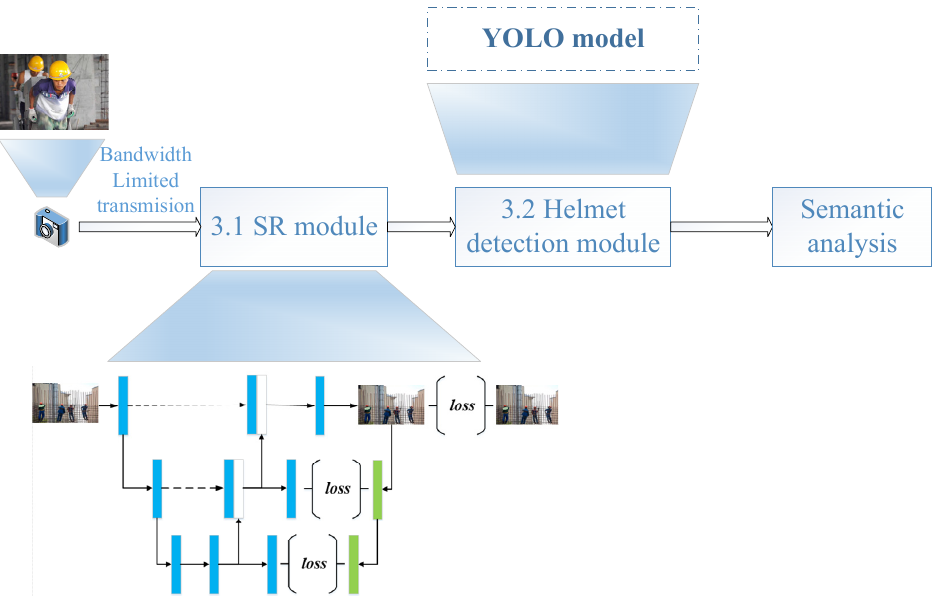
Figure 2. The workflow of the proposed end-to-end helmet monitoring system.